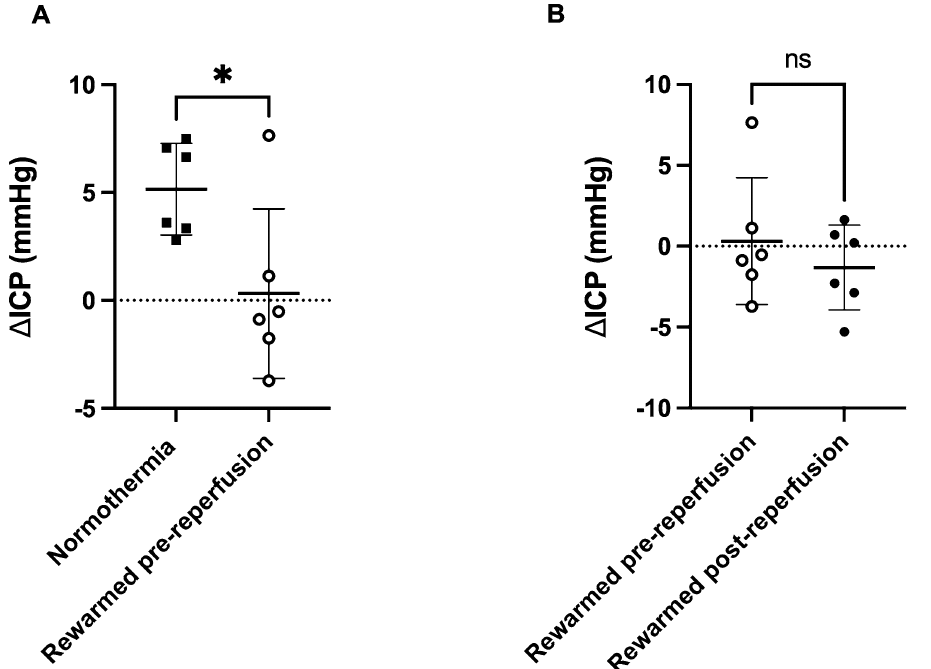
Figure 2. (A ) Change in ICP from baseline to 24 h (∆ICP) between rewarmed pre-reperfusion and normothermia groups 24 h post-stroke. ( B ) ∆ICP between rewarmed pre-reperfusion and rewarmed